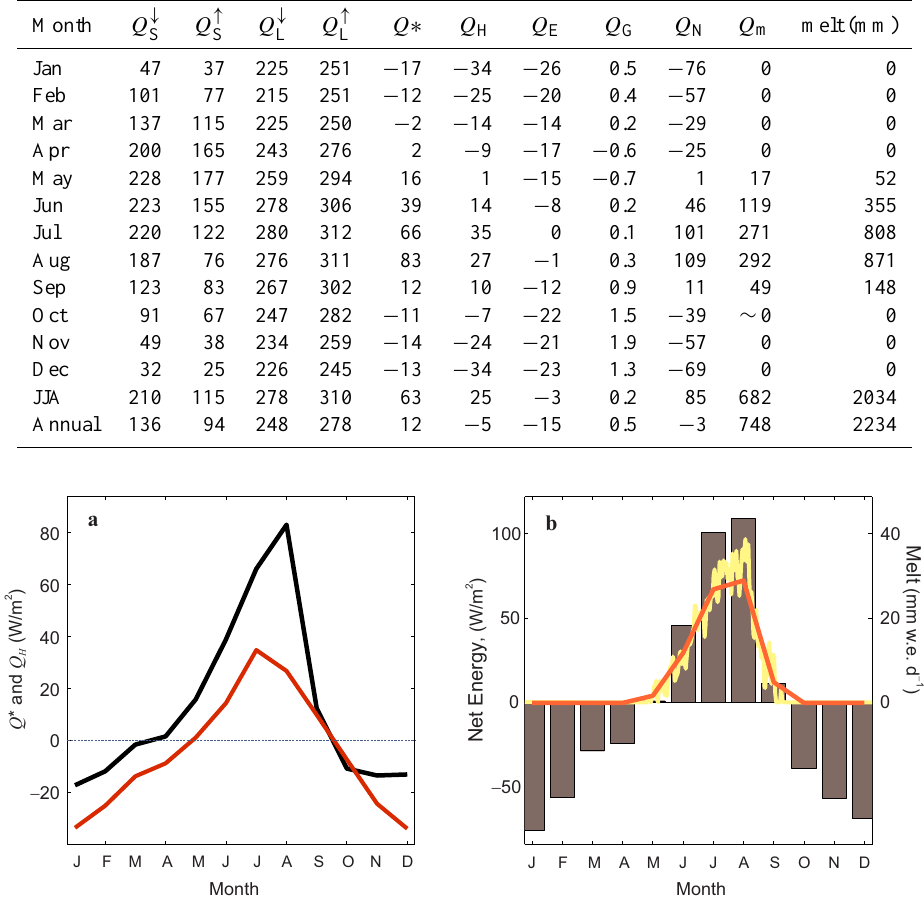
Figure 5. Mean monthly surface energy fluxes (Wm − 2 ) and melt rates (mmw.e.d − 1 ) at the glacier AWS, 2002–2012. (a) Net radiation, Q ∗ (black), and sensible heat flux, Q H (red). (b) Net energy, Q N (grey), daily melt rates (yellow line), and average monthly melt rates (orange